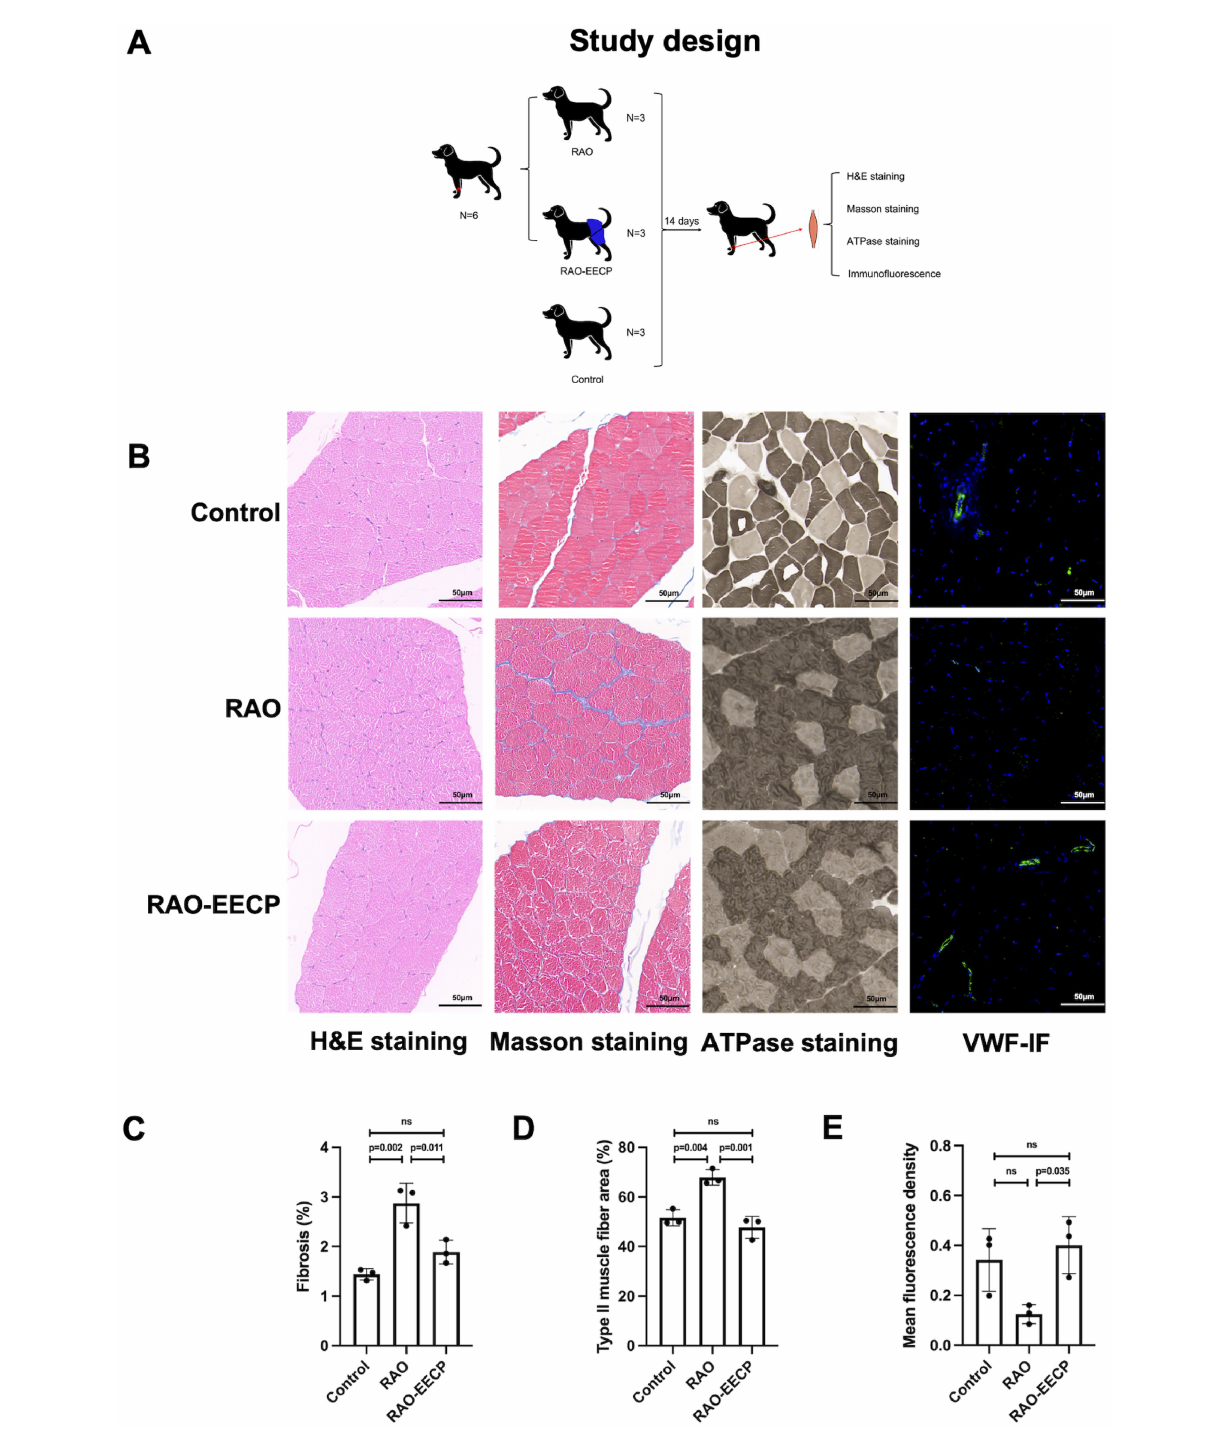
FIGURE 4 EECP promotes angiogenesis, improves muscle damage and aerobic metabolism. (A) Animal study design. (B) From left to right: H&E staining, Masson staining, ATPase staining and VWF immunofluorescence (IF) of cross section of lateral muscle of left forearm of Labrador dogs in three groups. Scale bars, 50 μ m. There was no significant difference in H&E staining among the three groups. VWF, Von Willebrand Factor. (C) Quantification of fibrotic regions (appearing as blue in Masson’s trichome in C ). Data were expressed as means ± SD ( n = 3 per group). Results were evaluated by